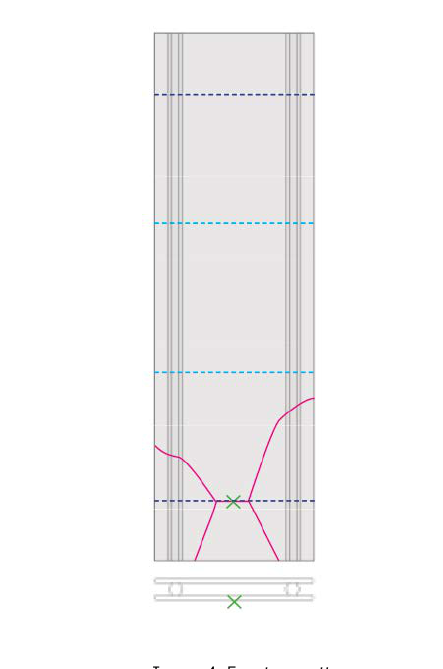
Image 6: panel penetrated by the support Image 4: Fracture pattern